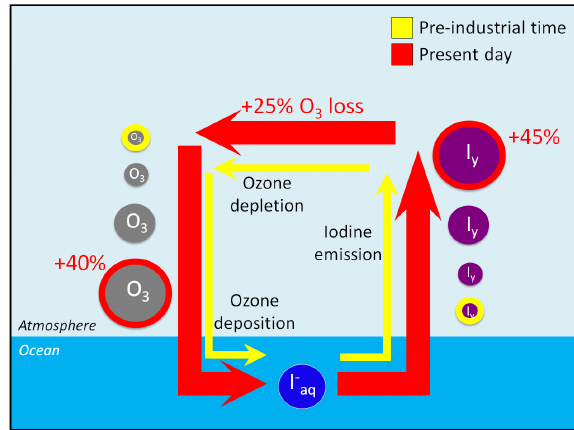
Figure 8. Geochemical feedback mechanism. The anthropogenic increase in tropospheric ozone during the last 2 centuries (20–55%; Myhre et al., 2013) has led to an amplification of the natural cycle of iodine emissions since pre-industrial times (PI cycle in yellow). This has consequently decreased the lifetime of ozone in the marine atmosphere and of its associated RF, thus closing a negative feed- back loop and presenting the ocean emissions of iodine as a natural mitigating factor for anthropogenic RF in the marine environment (PD cycle in